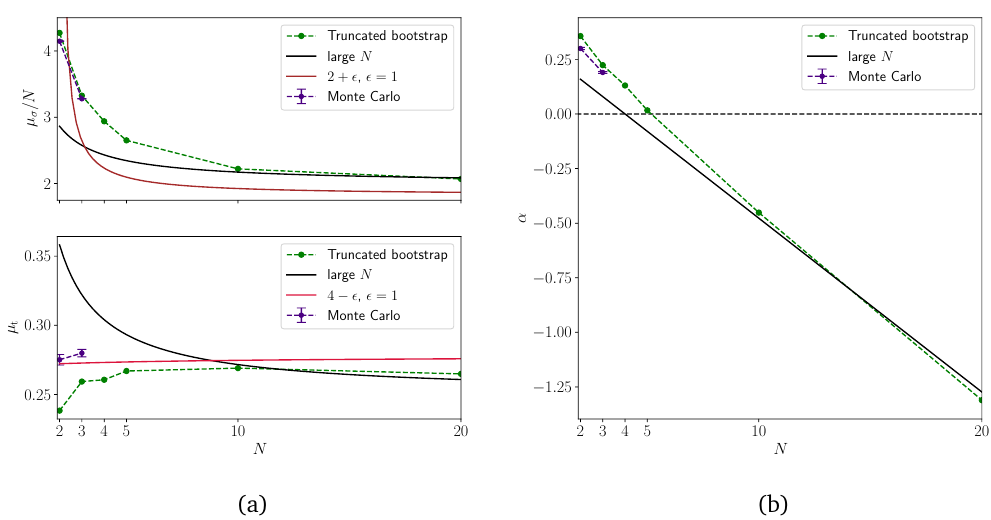
Figure 4: OPE coefficients from the truncated bootstrap. µ σ and µ left) compared to selected perturbative results (Appendix C) and Monte Carlo results in [ 41 ] . Corresponding values of α are on the right. The value of N ) = by α ( N c